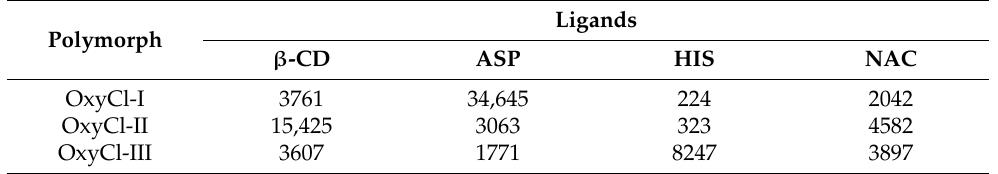
Table 1. Apparent binding constants K a (M − 1 ).